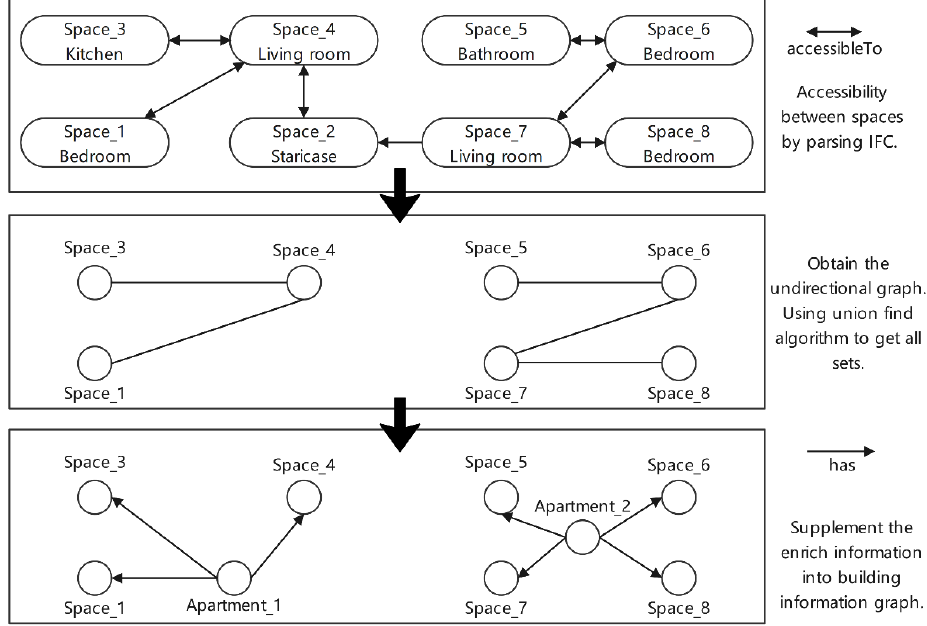
Figure 11. Union-find algorithm to identify the entities for “ apartment .”